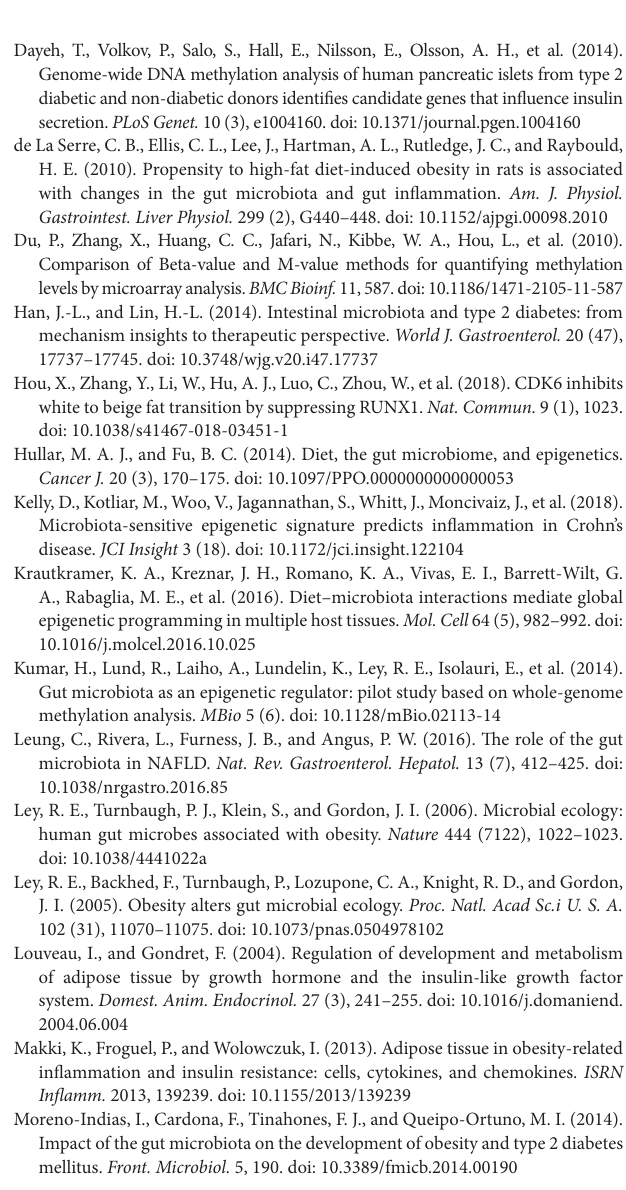
TABLE S7 | Pathway